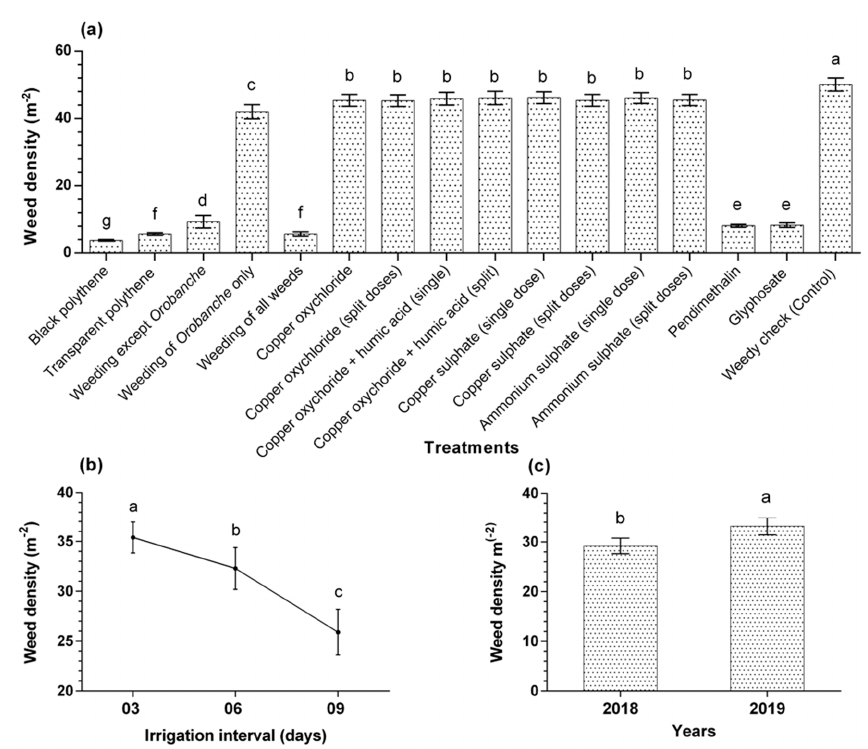
Figure 3. Response of weed density (m − 2 ) to various irrigation intervals and weed management treatments. ( a ) Effect of treatments on weed density. ( b ) Effect of irrigation intervals on weed density. ( c ) Effect of different years on weed density. Based on the Least significant difference test, line and column ± standard error followed by different alphabetical letters are significantly different from each other at 5% level of probability .